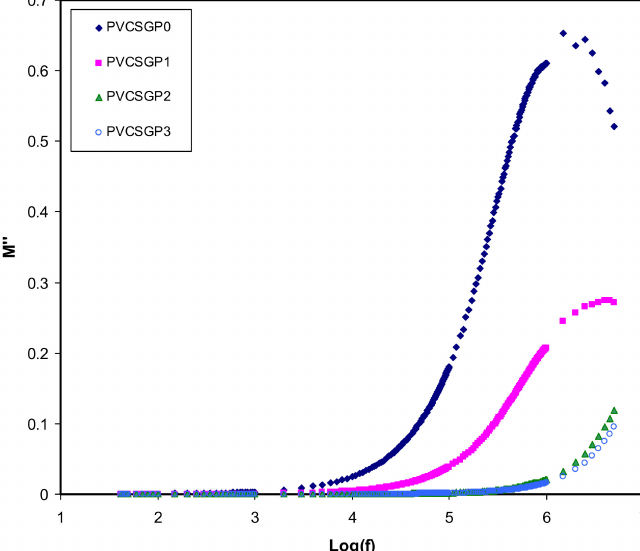
Figure 7. Imaginary part of electric modulus versus log (f) for all polymer-blend